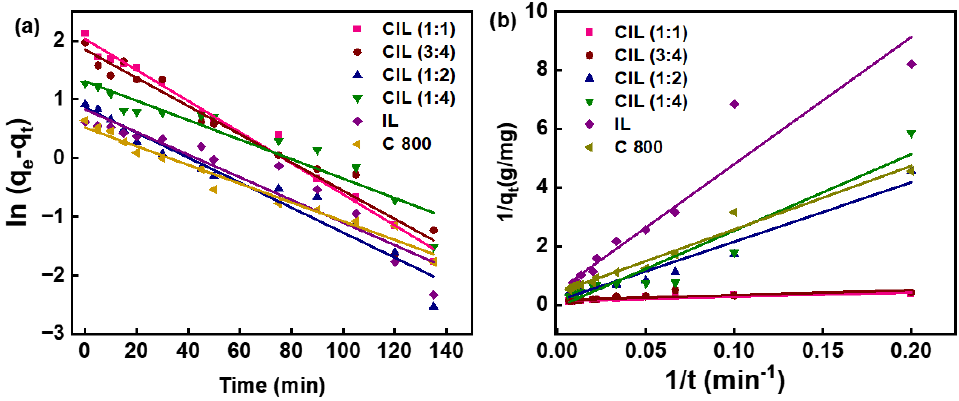
Figure 9. ( a ) Pseudo-first-order kinetics and ( b ) pseudo-second-order kinetics of adsorbing MB by the synthesized materials.